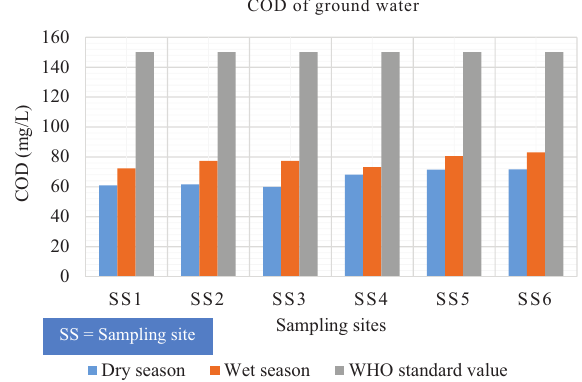
Figure 8. Seasonal variation in the COD of groundwater quality in the study area